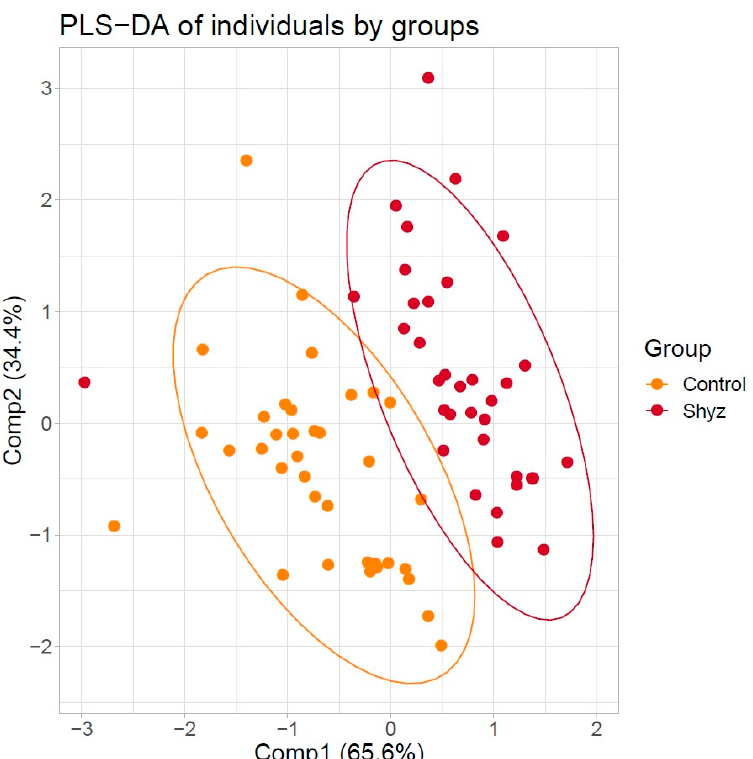
Figure 2. Scatter plot of 73 individuals by the first two principal components extracted from amino acids and acylcarnitines concentrations by partial least squares discriminant analysis (PSL-DA). Two distinct clusters were noted. Clusters are marked using red color for group patients with schizophrenia and orange color for healthy individuals.